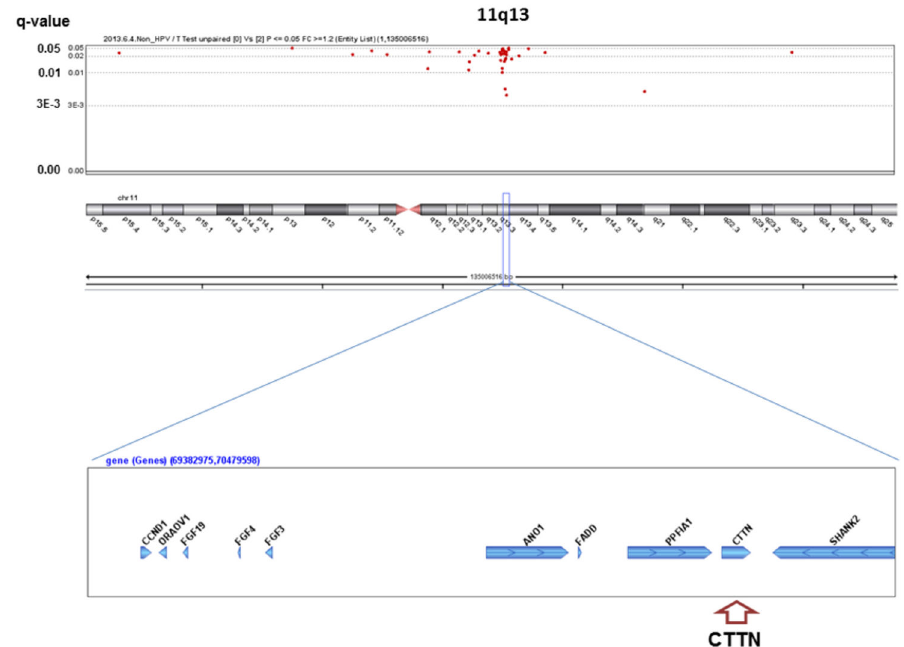
Figure 6. Significant SCNAs at 11q13 associated with heavy alcohol consumption. Significant q-values (<0.05) (y-axis) are plotted across the chromosome (x-axis). An oncogene or oncosuppressor gene associated with development of HNSCCs in previous studies is indicated in parentheses in each peak region. X and Y chromosomes were excluded for analysis, because alcohol drinkers and smokers were predominantly men.